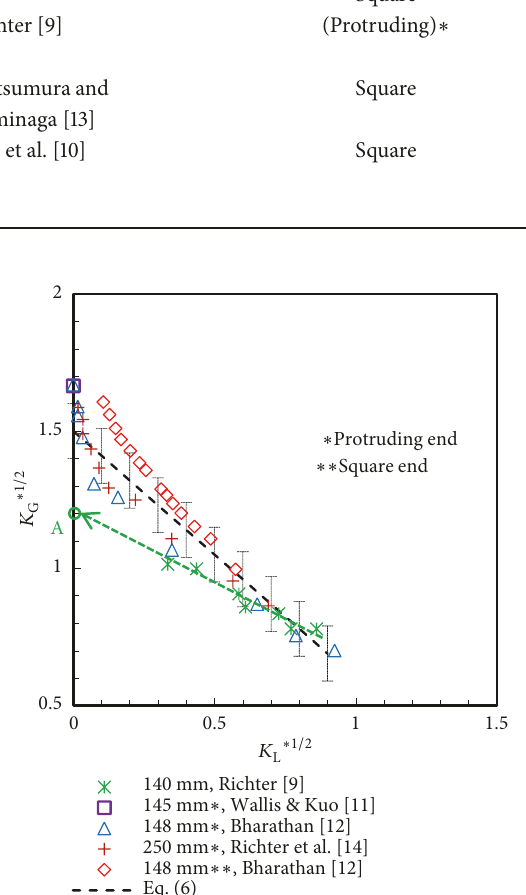
Figure 3: CCFL characteristics for large diameters and effects of protruding end (A: small 𝐶 K value by Richter [9] in Figure